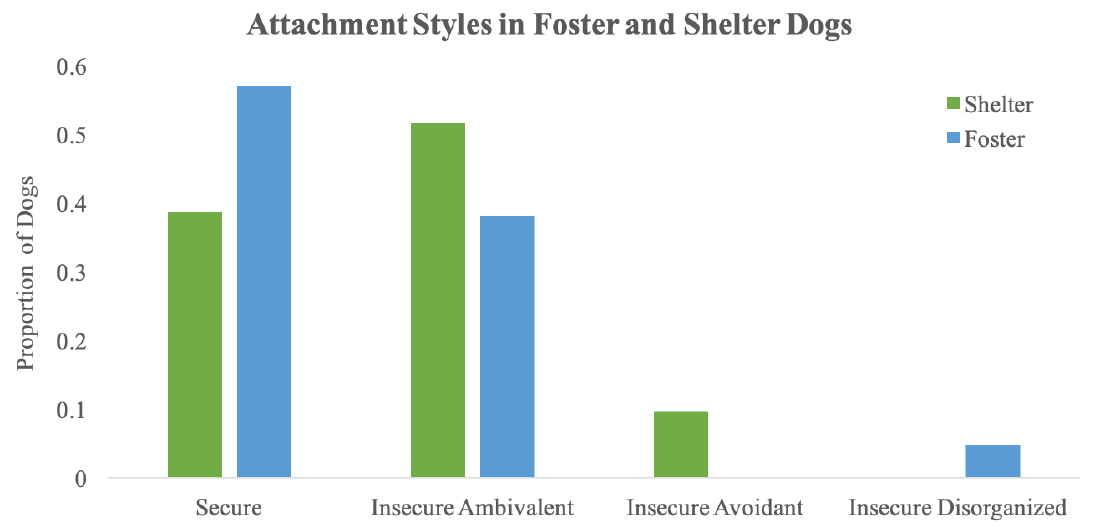
Figure 2. Proportion of dogs categorized into each attachment style for foster and shelter dog